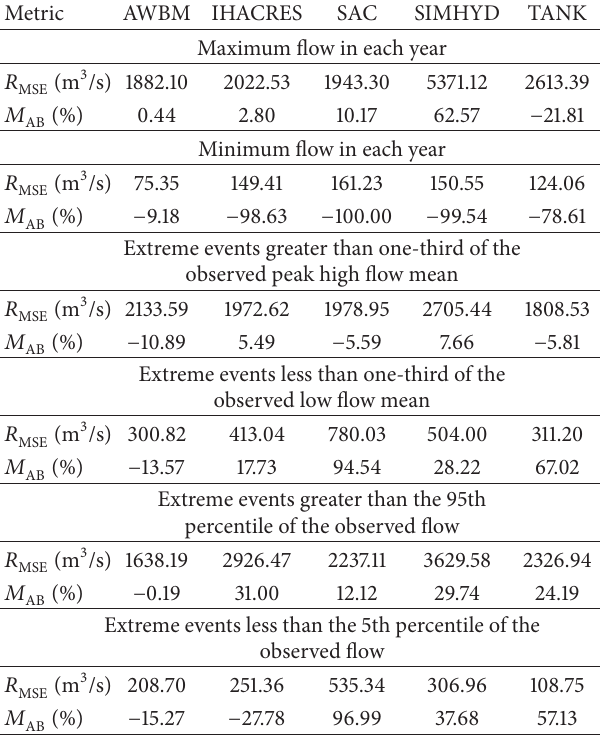
Table 4: Statistical measures of model performance for flow